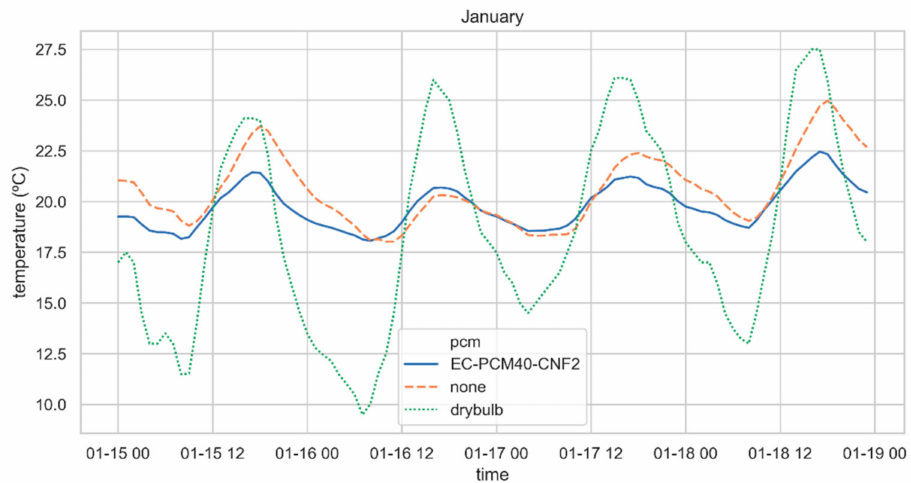
Figure 6. Indoor air temperature in case with EC-PCM40-CNF2 and without PCM and outside air drybulb temperature in Yuma during 72 h (from January 15th to January 17th) when there is not HVAC.